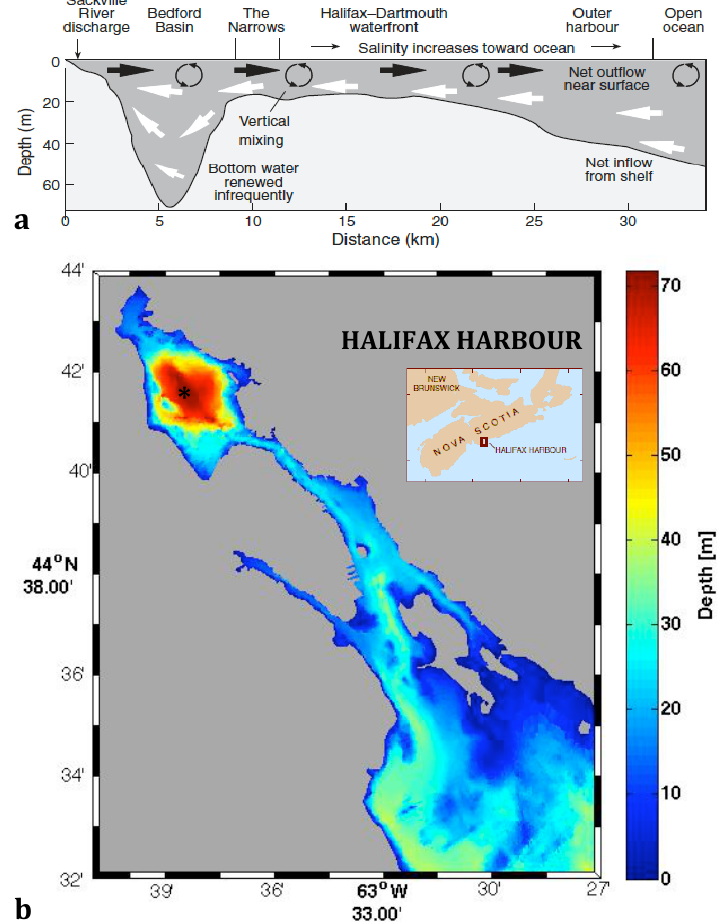
Fig. 1. (a) Schematic cross-section of Halifax Harbour (with permission from Fader and Miller, 2008). (b) Bathymetric map of Halifax Harbour, showing the Compass Buoy Site ( ∗